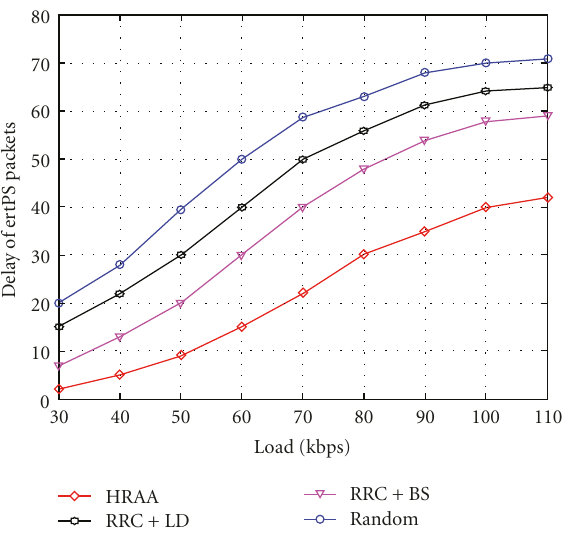
Figure 8: PLR comparison of rtPS SFs in inner cell versus